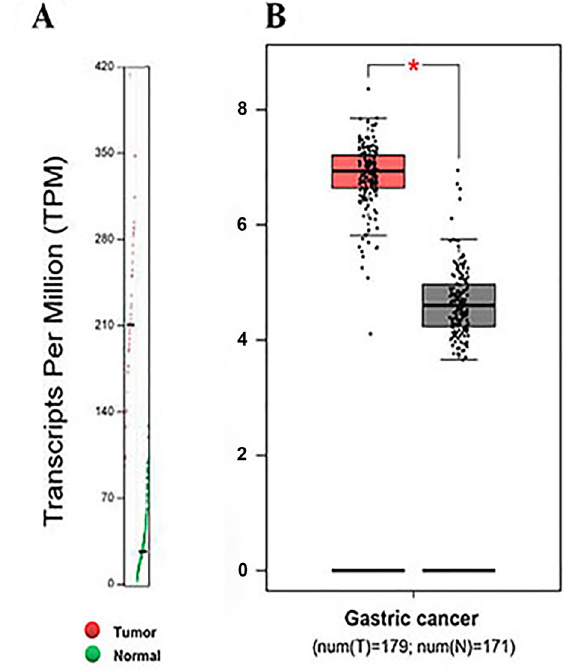
Figure 2. Transcripts per million (TPM) and mRNA levels of RBM8A in patients with gastric cancer and normal controls,